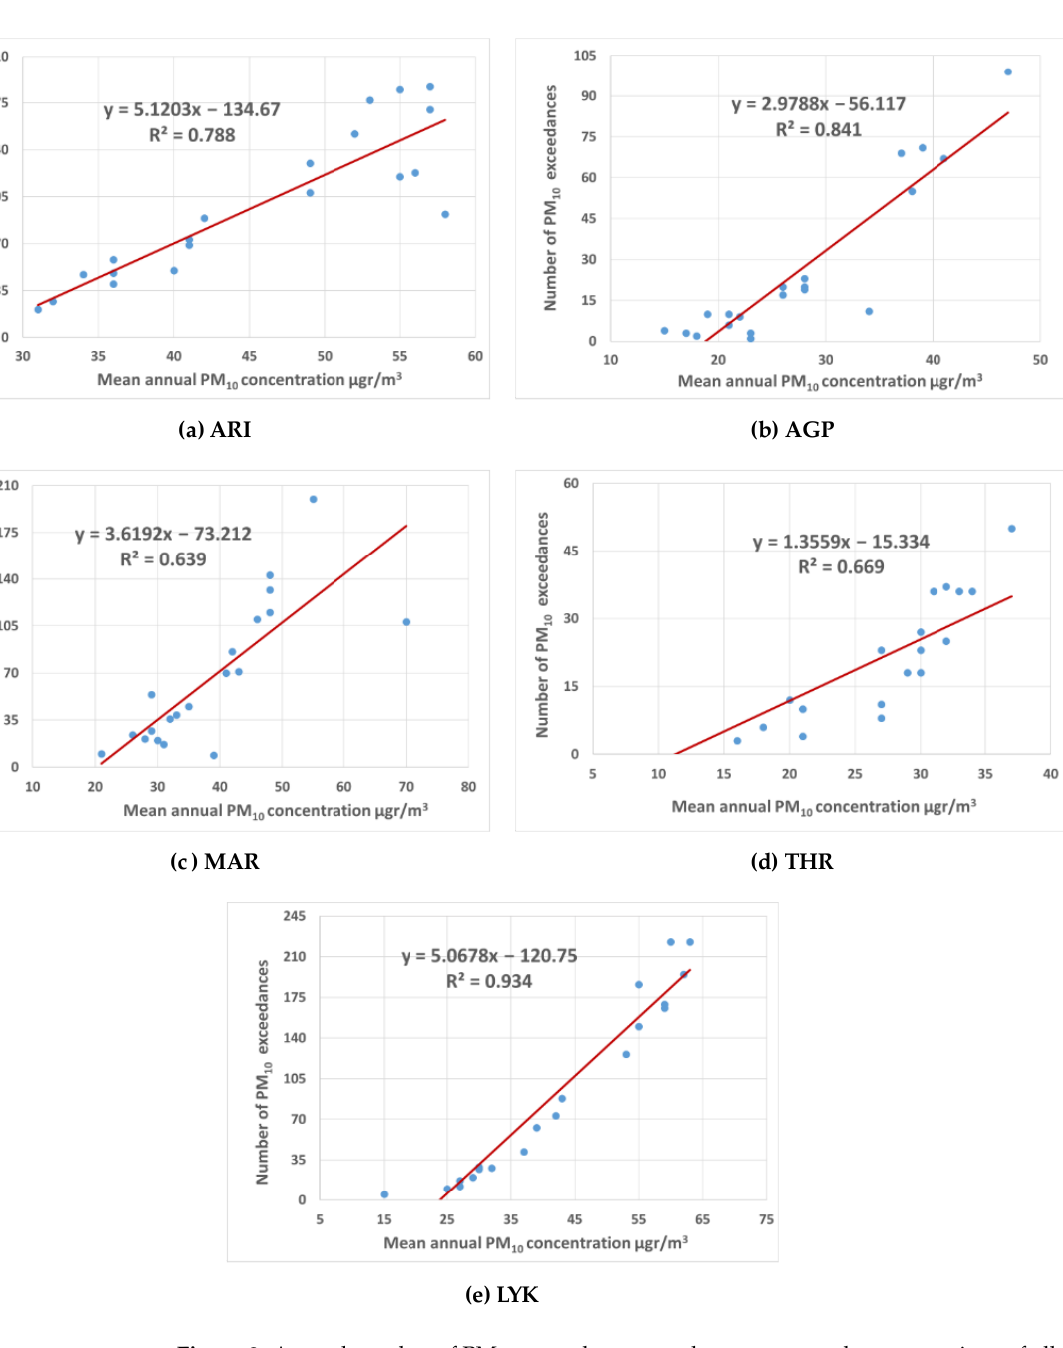
Figure 2. Annual number of PM 10 exceedances vs. the mean annual concentrations of all examined stations within the GAA.The red line refers to the central trendline. Period 2001 – 2020. (( a ): ARI, ( b ): AGP, ( c ): MAR, ( d ): THR, ( e ): LYK).